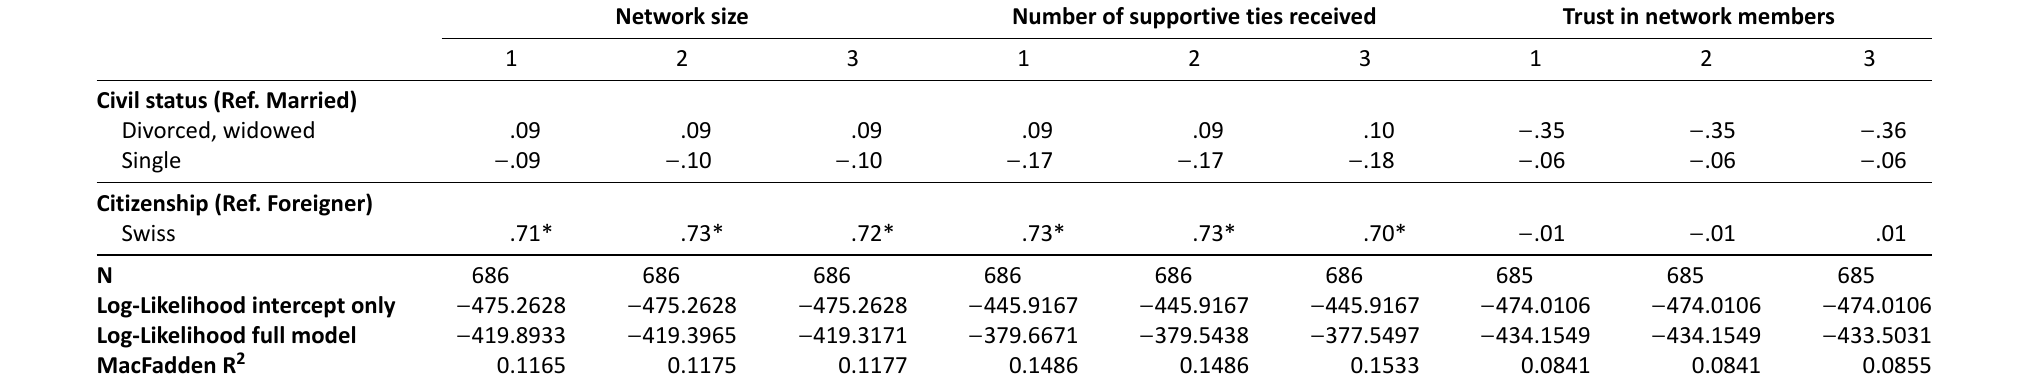
Table 2. Logistic regressions of social capital (beta coefficients). (Cont.)